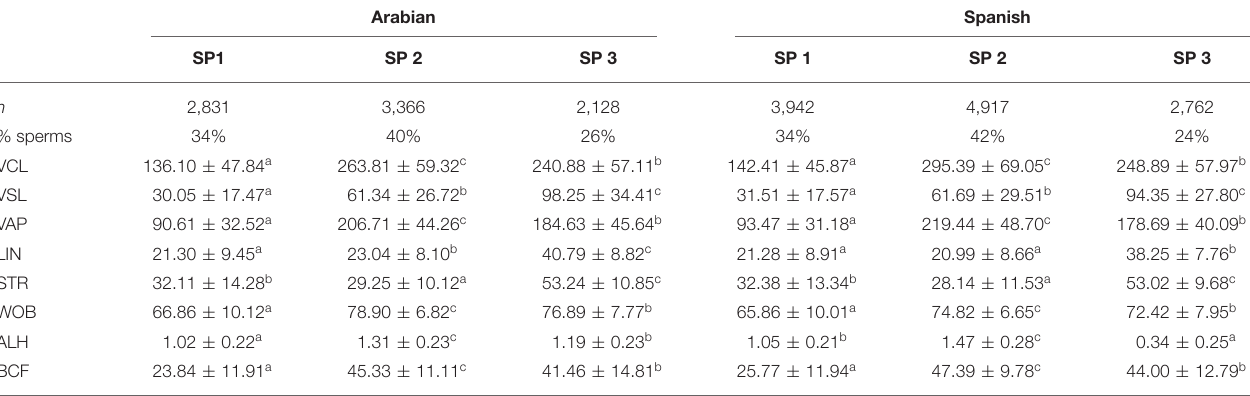
TABLE 4 | Descriptive statistics for the CASA-Mot variables (mean ± SEM) for each sperm subpopulation in two horse breeds, Arabian and Spanish. Arabian